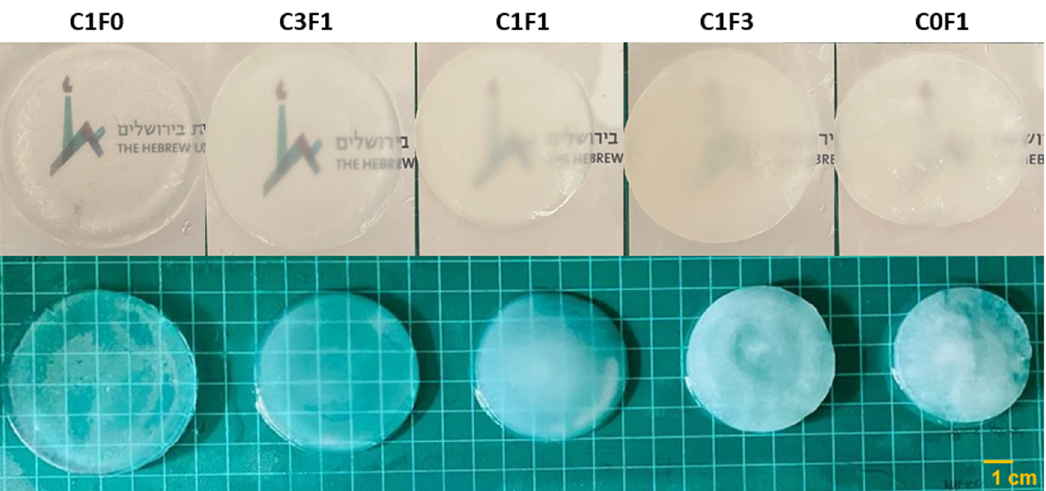
Figure 3. Illustrated overview of the fabricated hydrogels and their opacity in variable compositions. C1F0 fabricated with the addition of CNC alone, C0F1 fabricated with the addition of CNF alone, and C3F1, C1F1, and C1F3 fabricated with CNC and CNF at 3:1, 1:1, and 1:3, respectively.